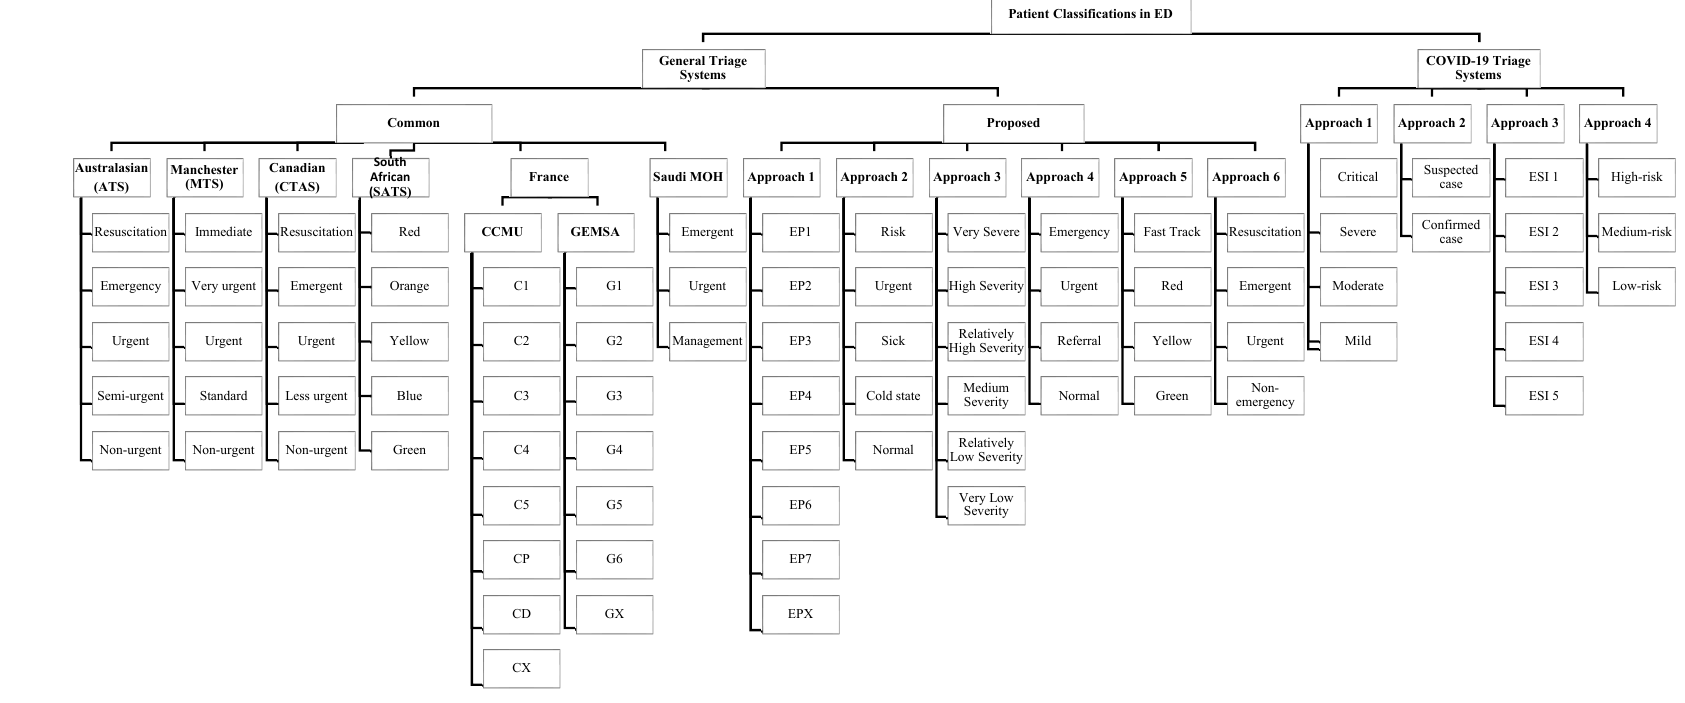
Figure 1. Patient classification approaches in EDs.